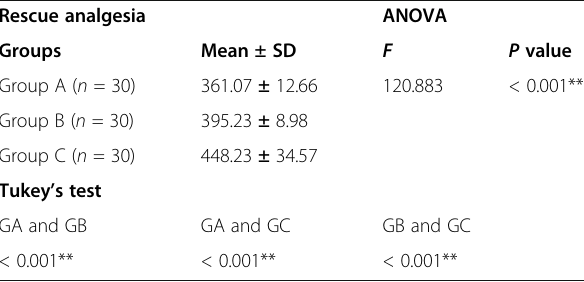
Table 4 Comparison between the three groups as regards time for request for rescue analgesia (post-operative